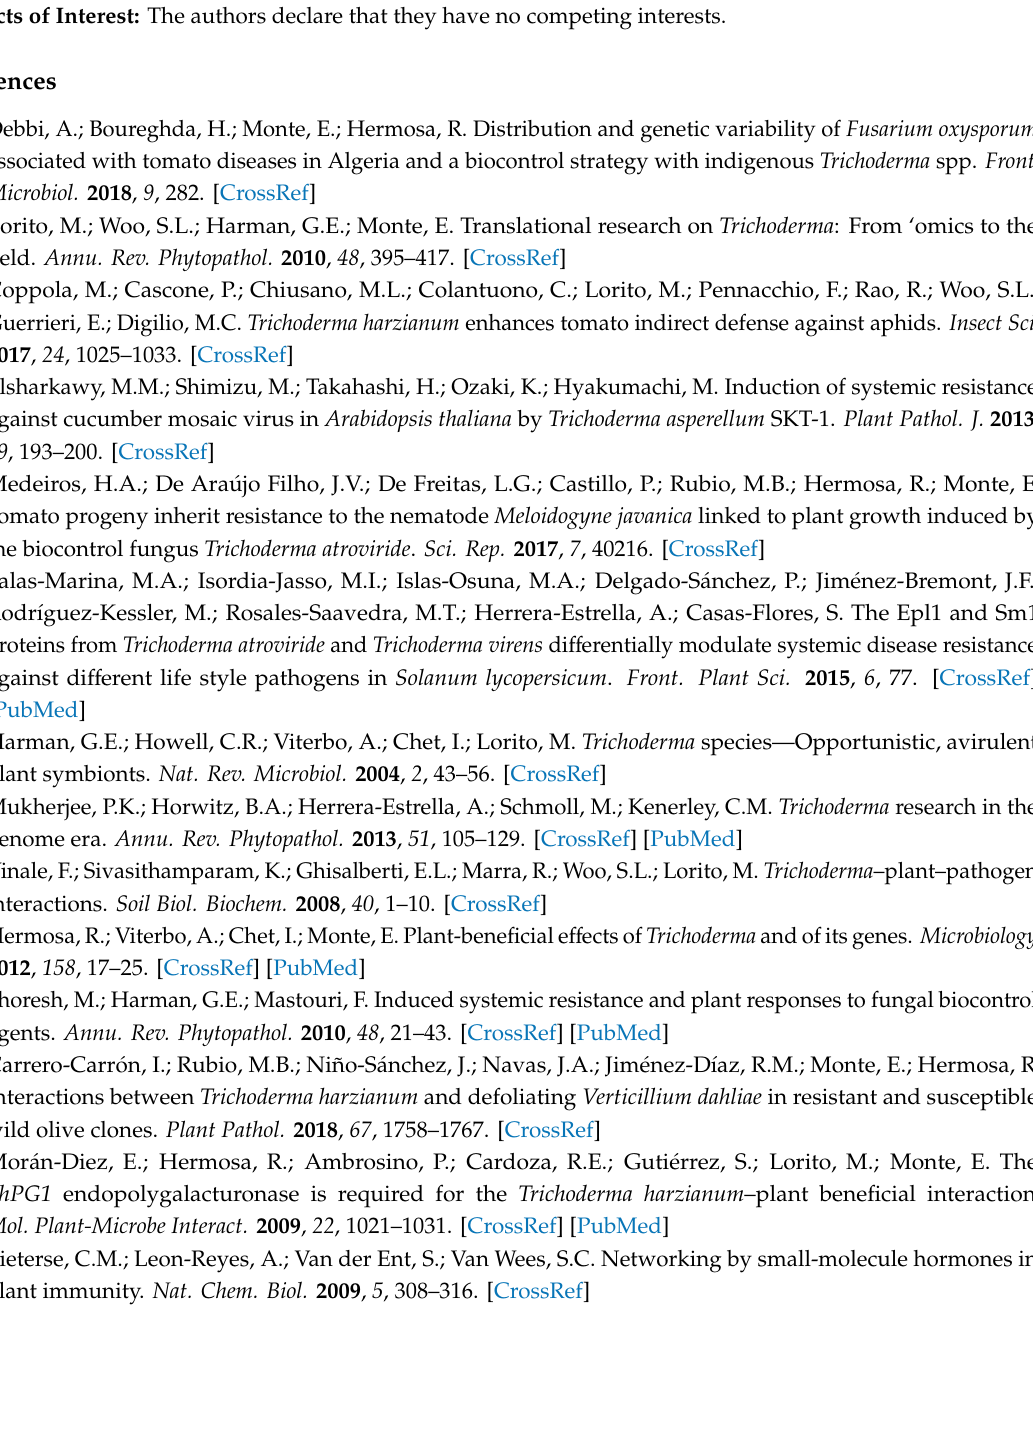
Figure S1: Drawing scheme of tomato leaflets collected for counting bacterial population and for RNA extractions in this study, Table S1: List of specific primer pairs used in this study, Table S2: E ff ect of Pst and Trichoderma treatments on gene